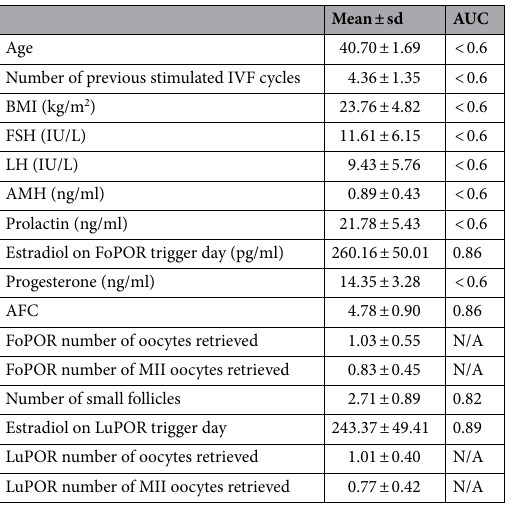
Table 1. Descriptive statistics of participant general